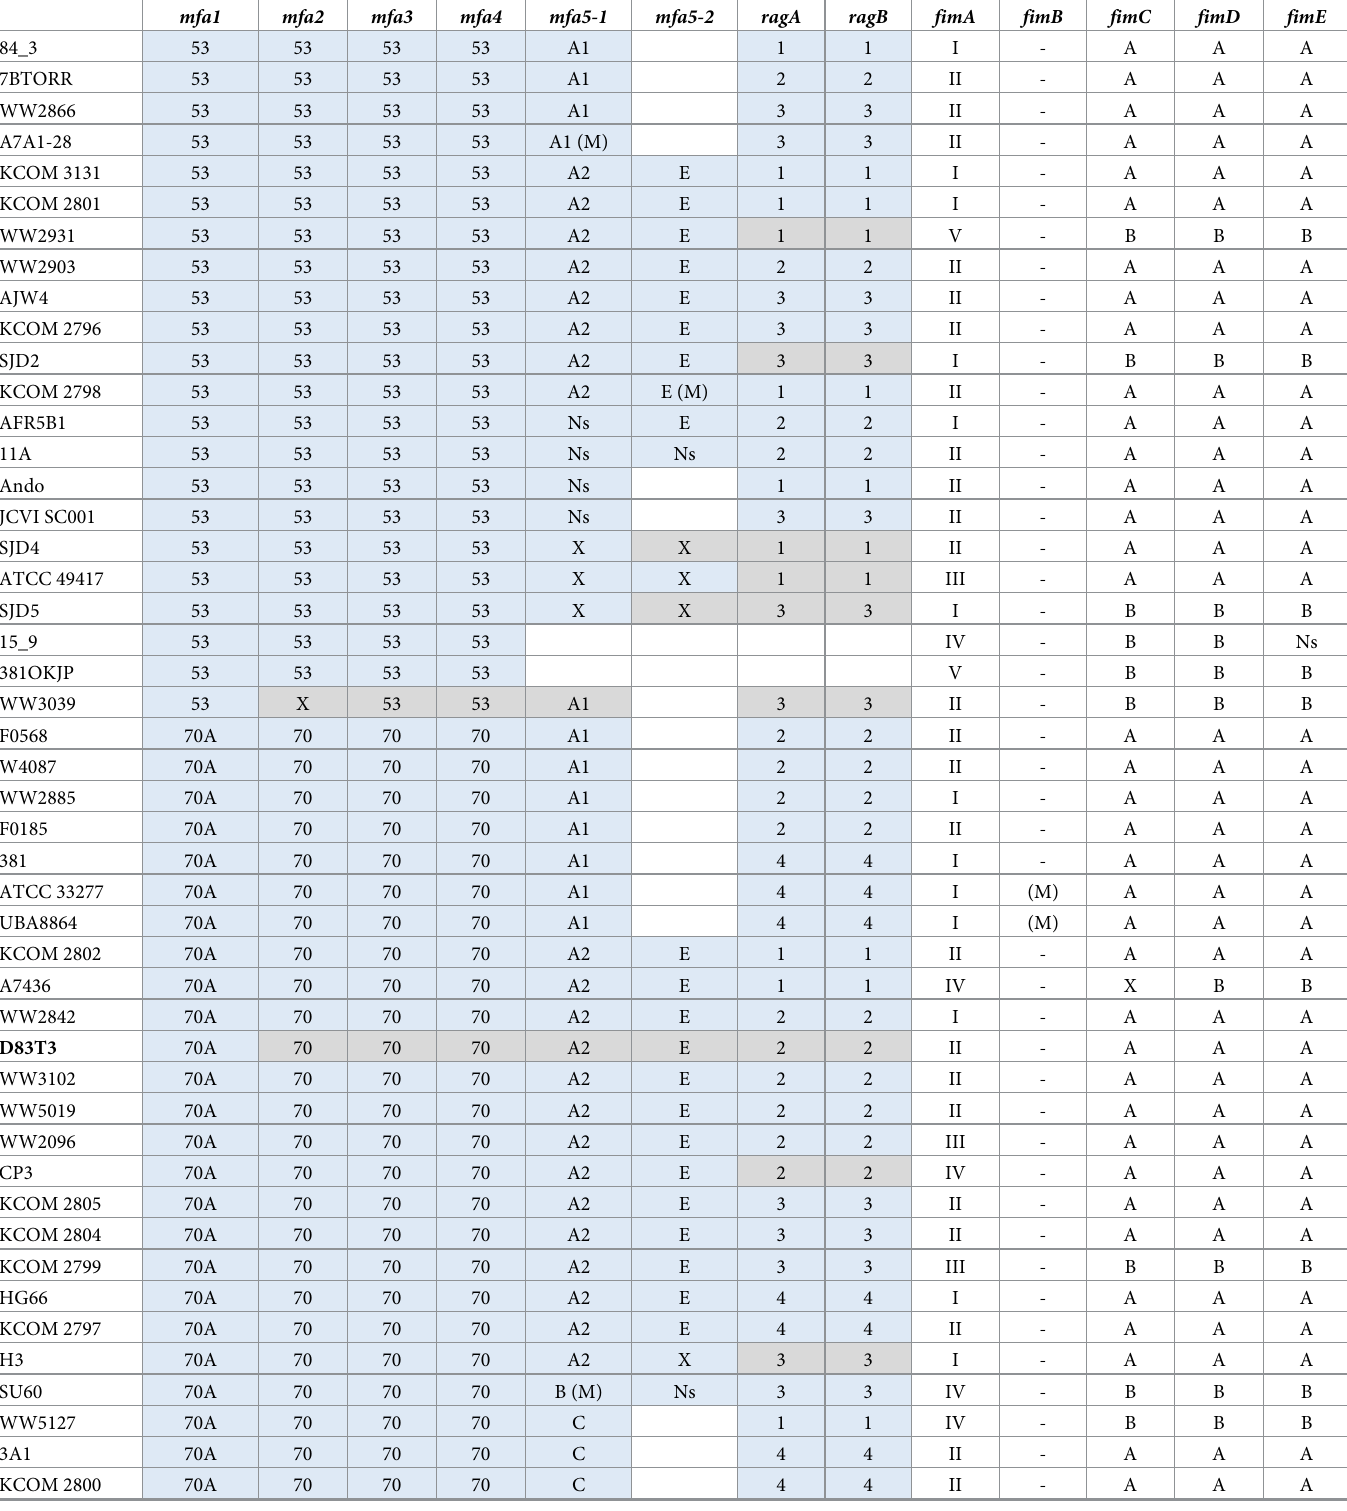
Table 3. Genotypes in the mfa , rag , and fim gene